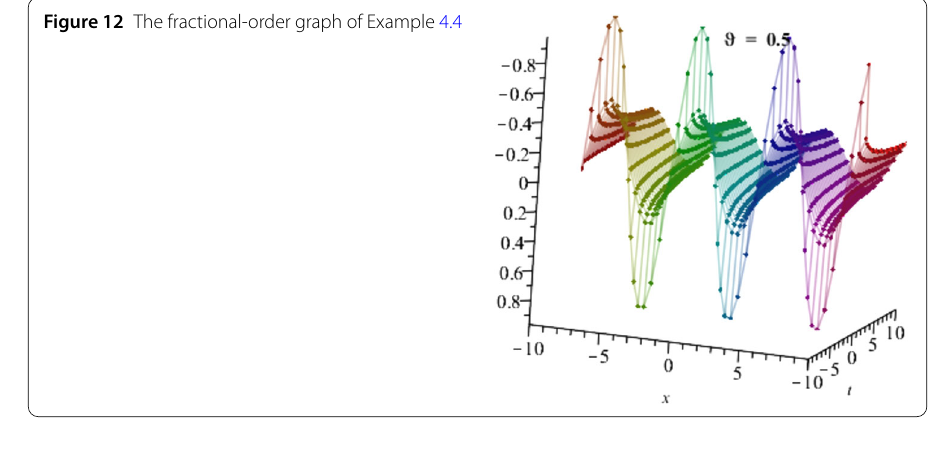
Figure 12 The fractional-order graph of Example